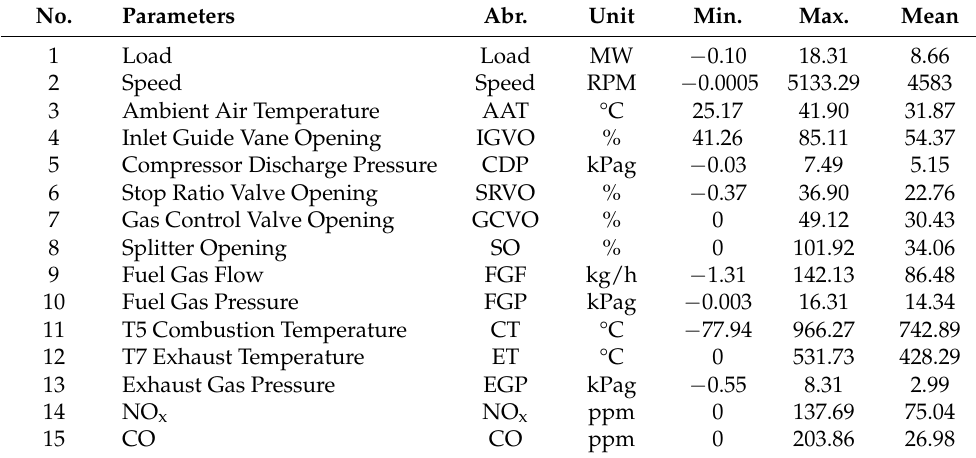
Table 2. DLE gas turbine’s parameters collected from the actual